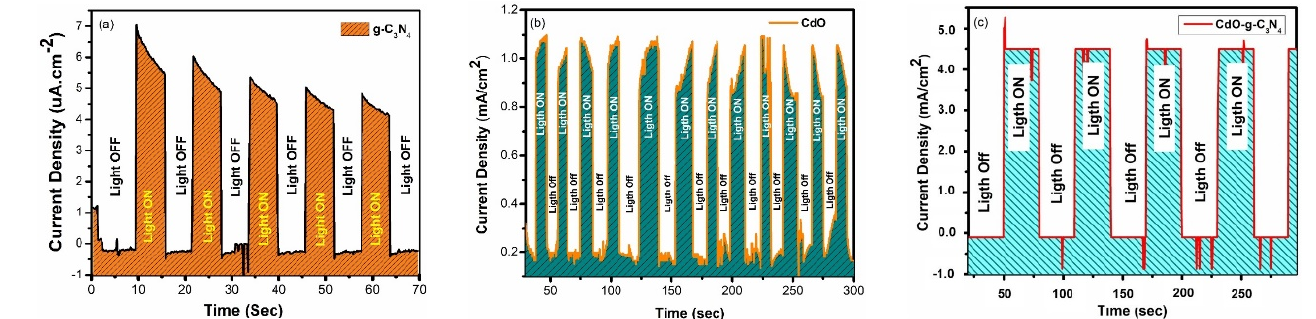
Figure 6. Chronoamperometric responses recorded at Open Circuit Potential (0 V applied potential) for ( a ) g-C 3 N 4 nanosheets ( b ) CdO -nanorods and ( c ) CdO-g-C 3 N 4 nanocomposite in 0.5 M NaSO 4 electrolyte by a three-electrode system under chopped on/off light from a solar simulator of AM 1.5 G filter and 100 mW cm − 2 (1Sun) light intensity of Xe lamp.